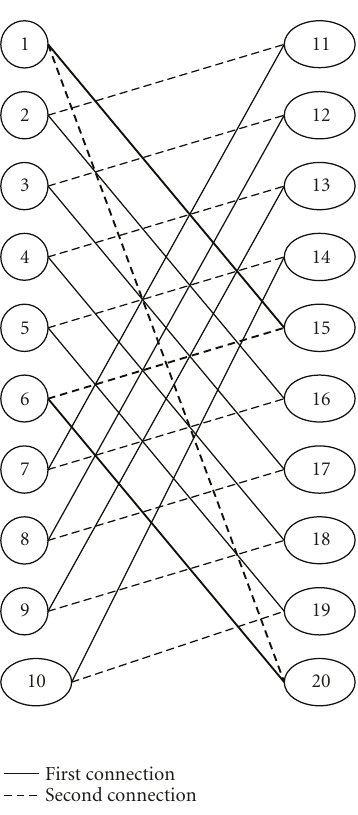
Figure 6: Formation of smaller cycles than the target